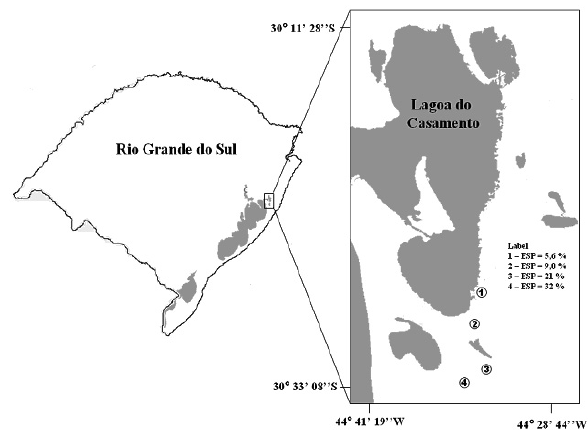
Figure 1. Location of the studied